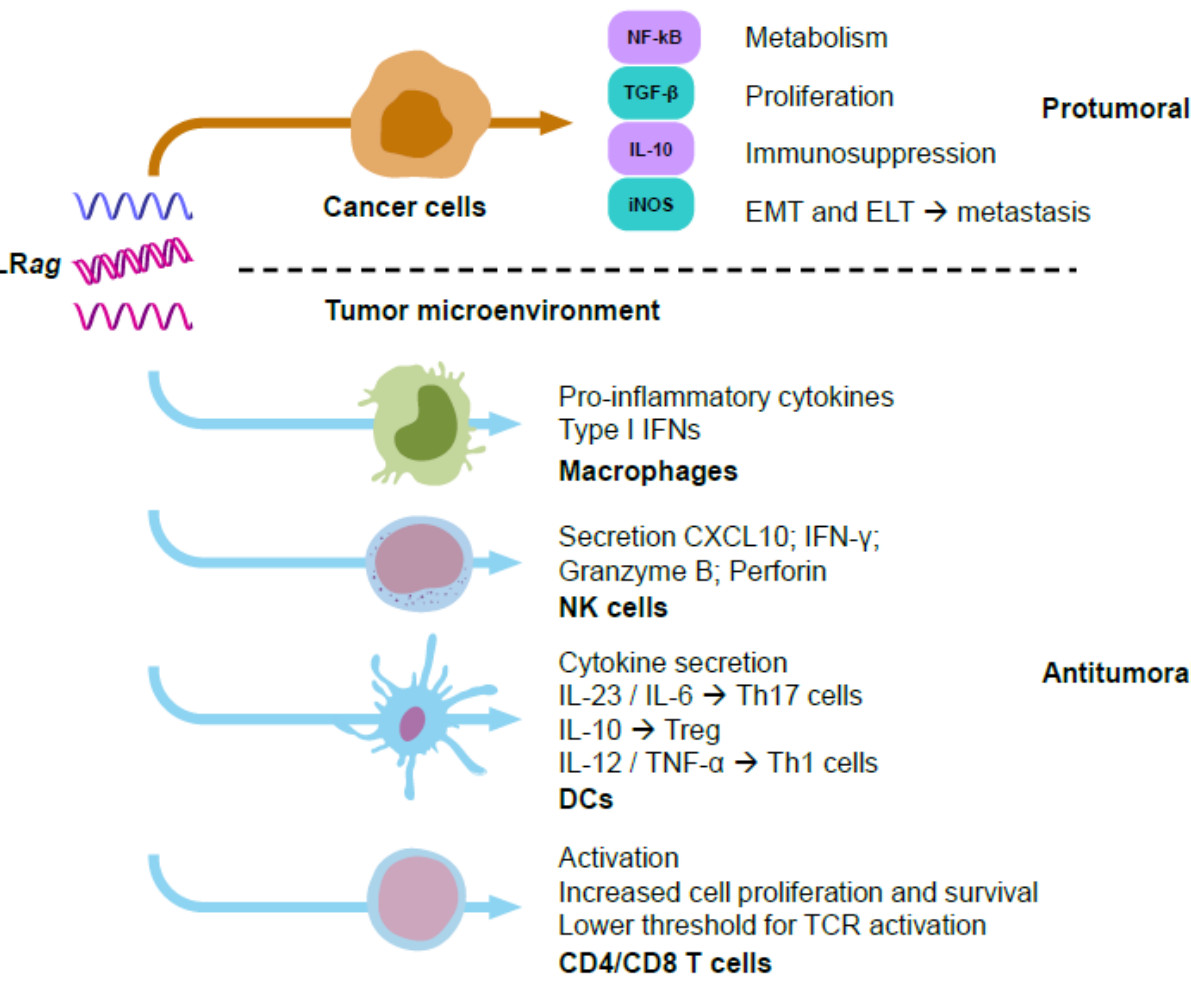
Figure 2. Schematic representation of responses triggered by TLR ag in cancer cells (mainly with a protumoral effect) versus immune cells (mainly with antitumoral immune responses). Many experimental studies have shown the activation of protumoral functions by TLR agonists on cancer cells, such as increasing their metabolism and proliferation, epithelial–mesenchymal/leucocytic transition, metastasis, and immunosuppression. On the other hand, TLR agonists activate antitumoral functions on immune cells, such as secretion of pro-inflammatory cytokines, Type I IFNs, increase in levels of perforins or granzyme B, as well as proliferation and recruitment of immune cells to fight against cancer cells.